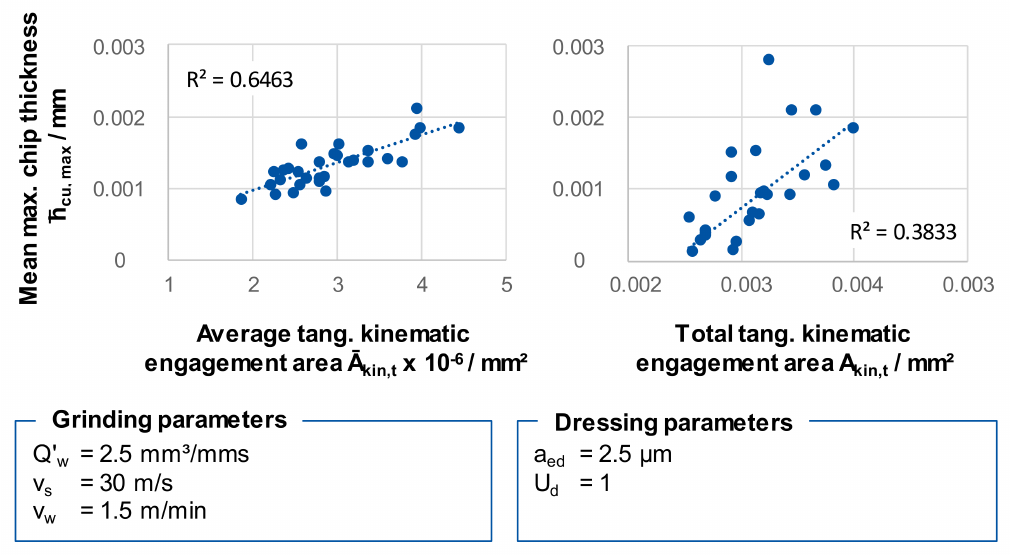
Figure 10. Correlation between kinematic engagement grain area and chip thickness.